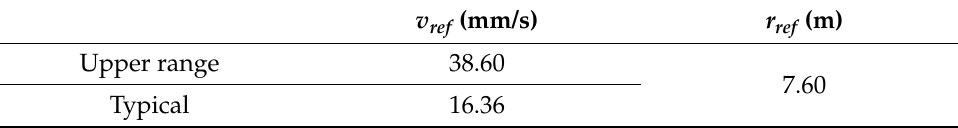
Table 1. Reference vibration levels for impact pile driving